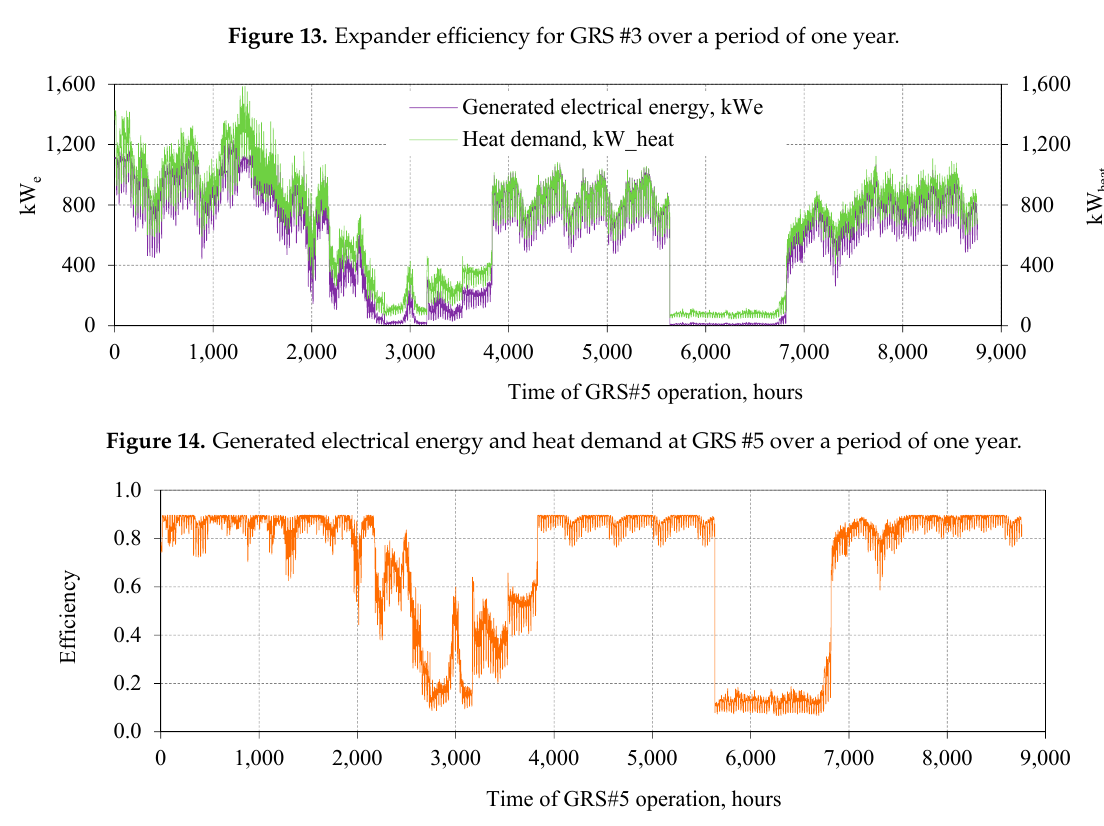
Figure 15. Expander efficiency for GRS #5 over a period of one year.